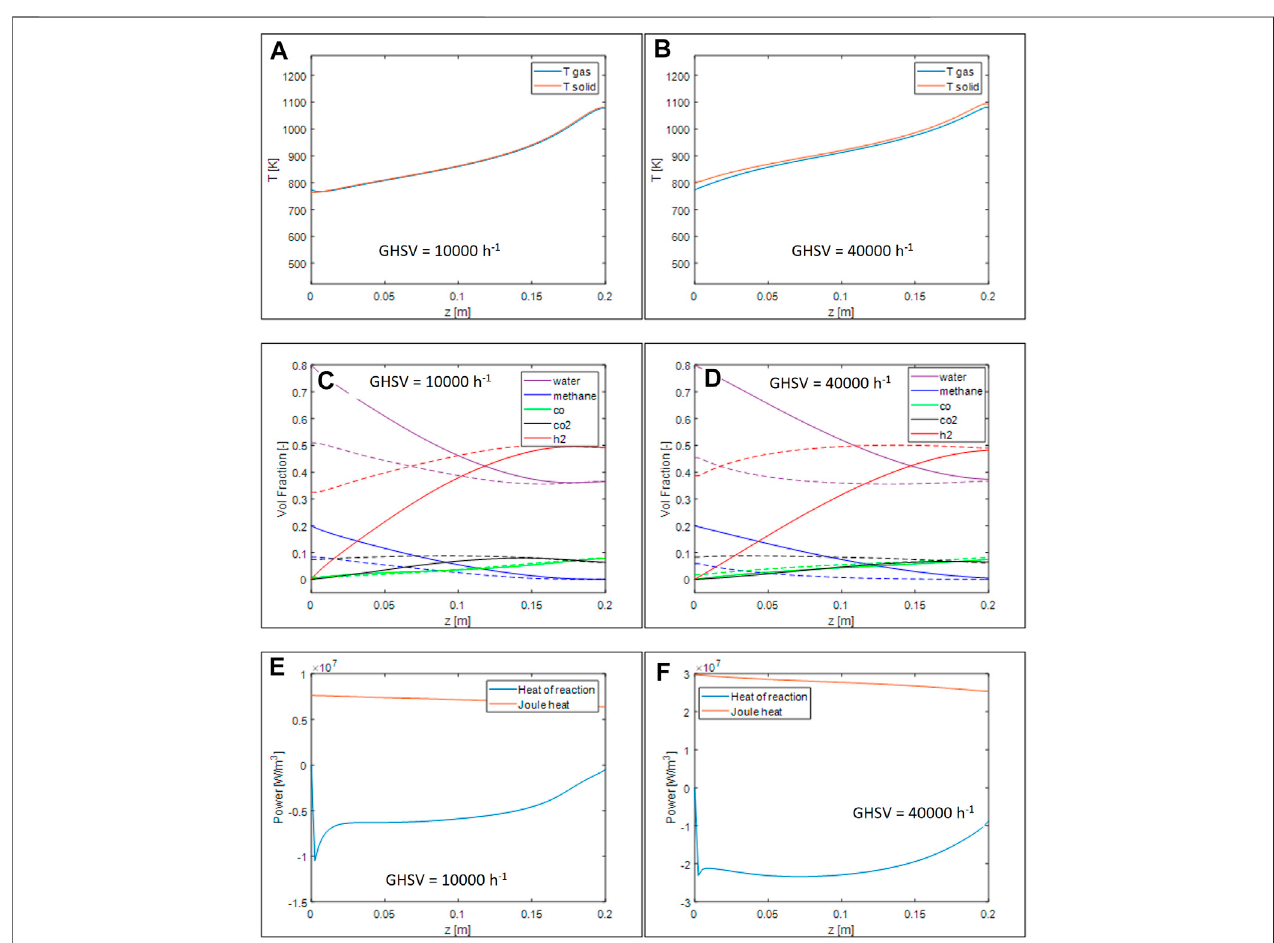
FIGURE 4| Simulations of200 CPSI OFA 0.8 monoliths with conditions reported in Table 4 . Axial temperature pro fi les for GHSV (cid:2) 10.000 h − 1 (A) and 40.000 h − 1 (B) ,volumetricfractionaxialpro fi leforGHSV (cid:2) 10.000h − 1 (C) and40.000h − 1 (D) ,thermalpowergeneratedandrequiredbythereactionforGHSV (cid:2) 10.000h − 1 (E) and 40.000 h − 1 (F)